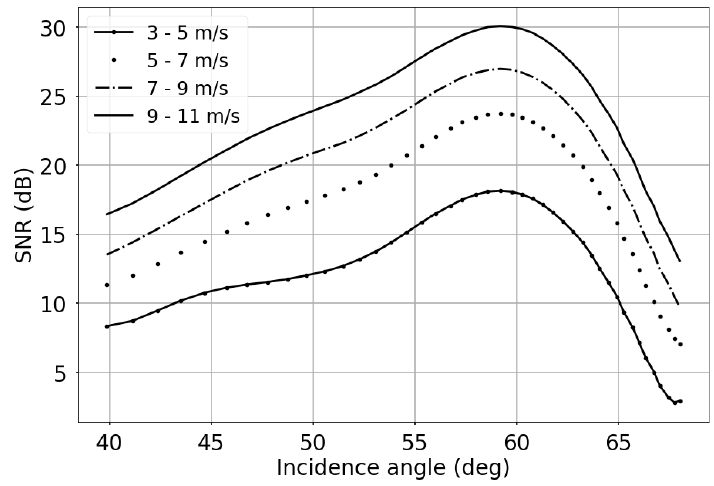
Figure 4. Signal-to-noise ratio (SNR) with respect to the radar incidence angle for different wind speed ranges: 3–5 m/s (dot-solid), 5–7 m/s (dot), 7–9 m/s (dot-dashed), 9–11 m/s